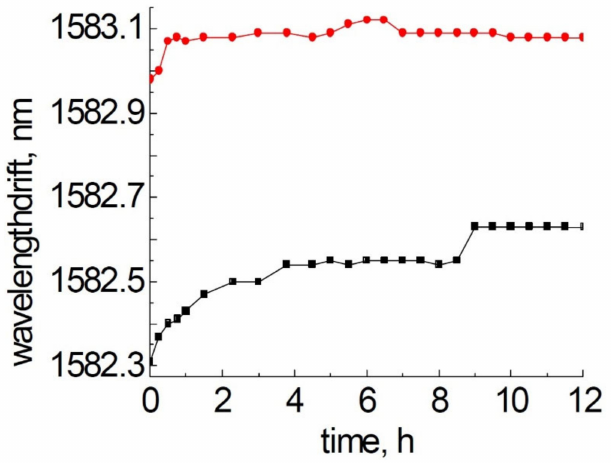
Figure 7. Bragg wavelength drift of Type II FBGs in SMF-28 (black squares) and H 2 -loaded SMF-28 (red circles) at 1000 ◦ C, data reproduced from